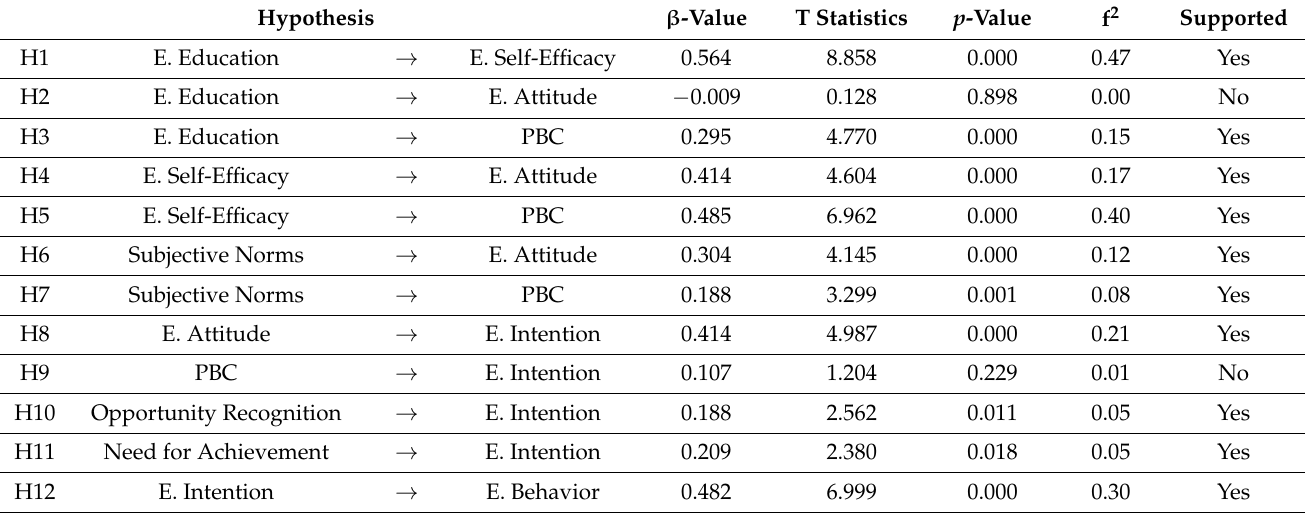
Table 5. Hypotheses testing